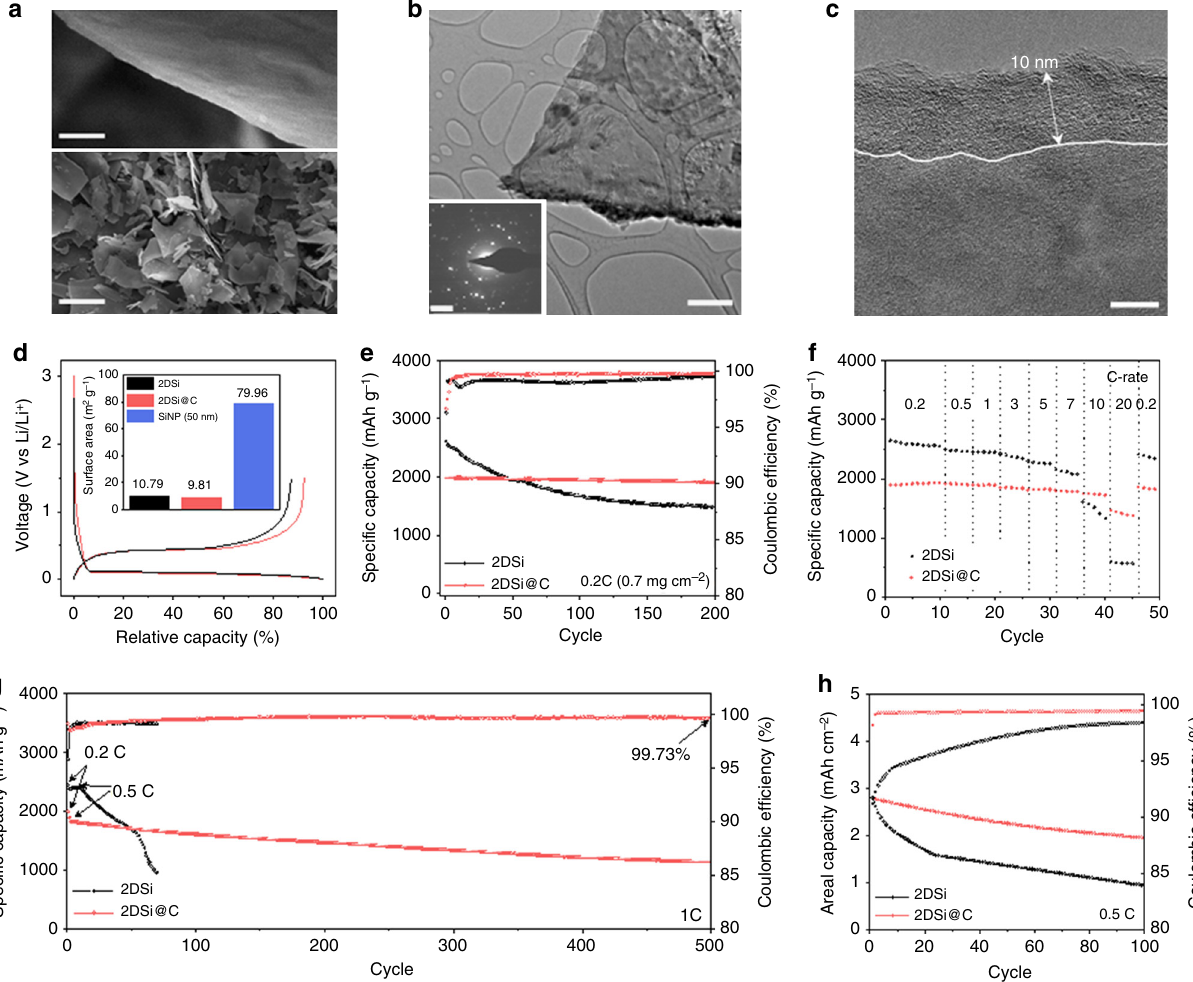
Fig. 1 Physical and electrochemical characterization of 2DSi-based anodes. a SEM images of 2DSi with high and low magni fi cations. b A TEM image of 2DSi@C, inset shows the typical SAED patterns of polycrystalline Si. c A high magni fi cation TEM image, showing 5 – 10 nm amorphous carbon layers coated on the 2DSi. d – h The side-by-side comparison of half-cell electrochemical performance between 2DSi and 2DSi@C electrodes on initial galvanostatic voltage pro fi les ( d , inset: surface area results of 2DSi, 2DSi@C, and SiNP), capacity retention at 0.2 C-rate ( e ), rate capability at different C-rate from 0.2 C to 20 C for each 5 cycles ( f ), long-term stability at 1 C-rate ( g ), and capacity retention of full-cell paired with LiCoO 2 cathode ( h ), respectively. Scale